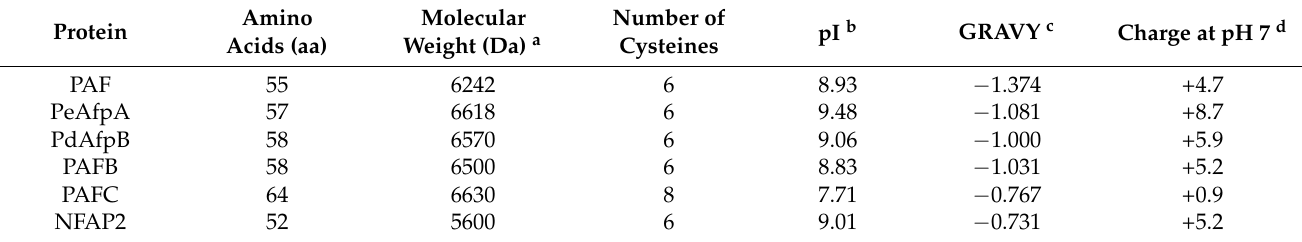
Table 1. Predicted physicochemical properties of mature antifungal proteins used in this work. Amino Acids Protein Amino Molecular Protein Acids (aa) Weight (Da) a PAF